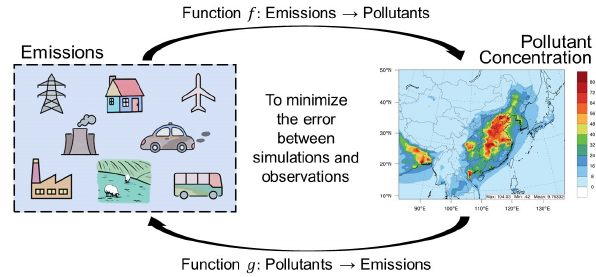
Figure 1. Framework of this